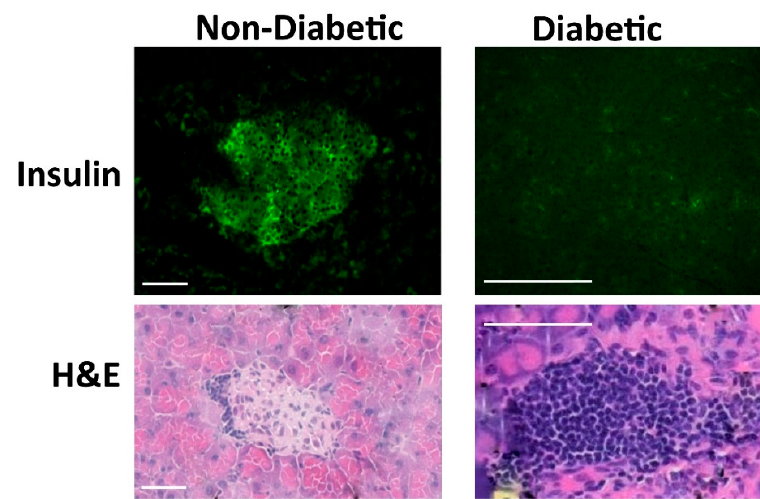
Figure 4. Immunohistochemical analysis of insulin (upper panels) and hematoxylin and eosin (H&E; insulitis) (lower panels) staining in pancreatic islet samples from representative untreated NOD mice that were non-diabetic (left panels) or diabetic (right panels). Scale bars = 50 µm.